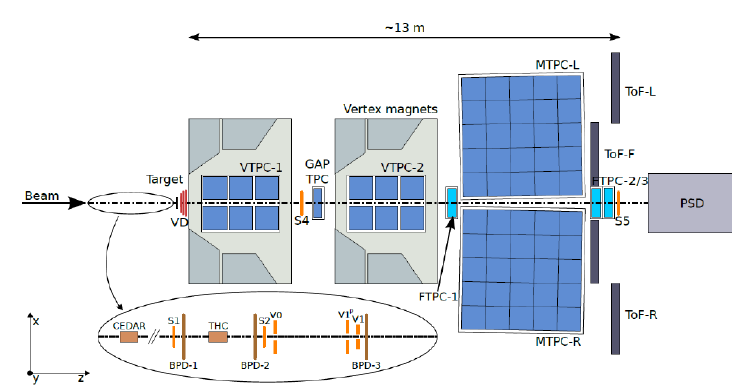
Figure 1. Schematic view of the NA61 / SHINE detector